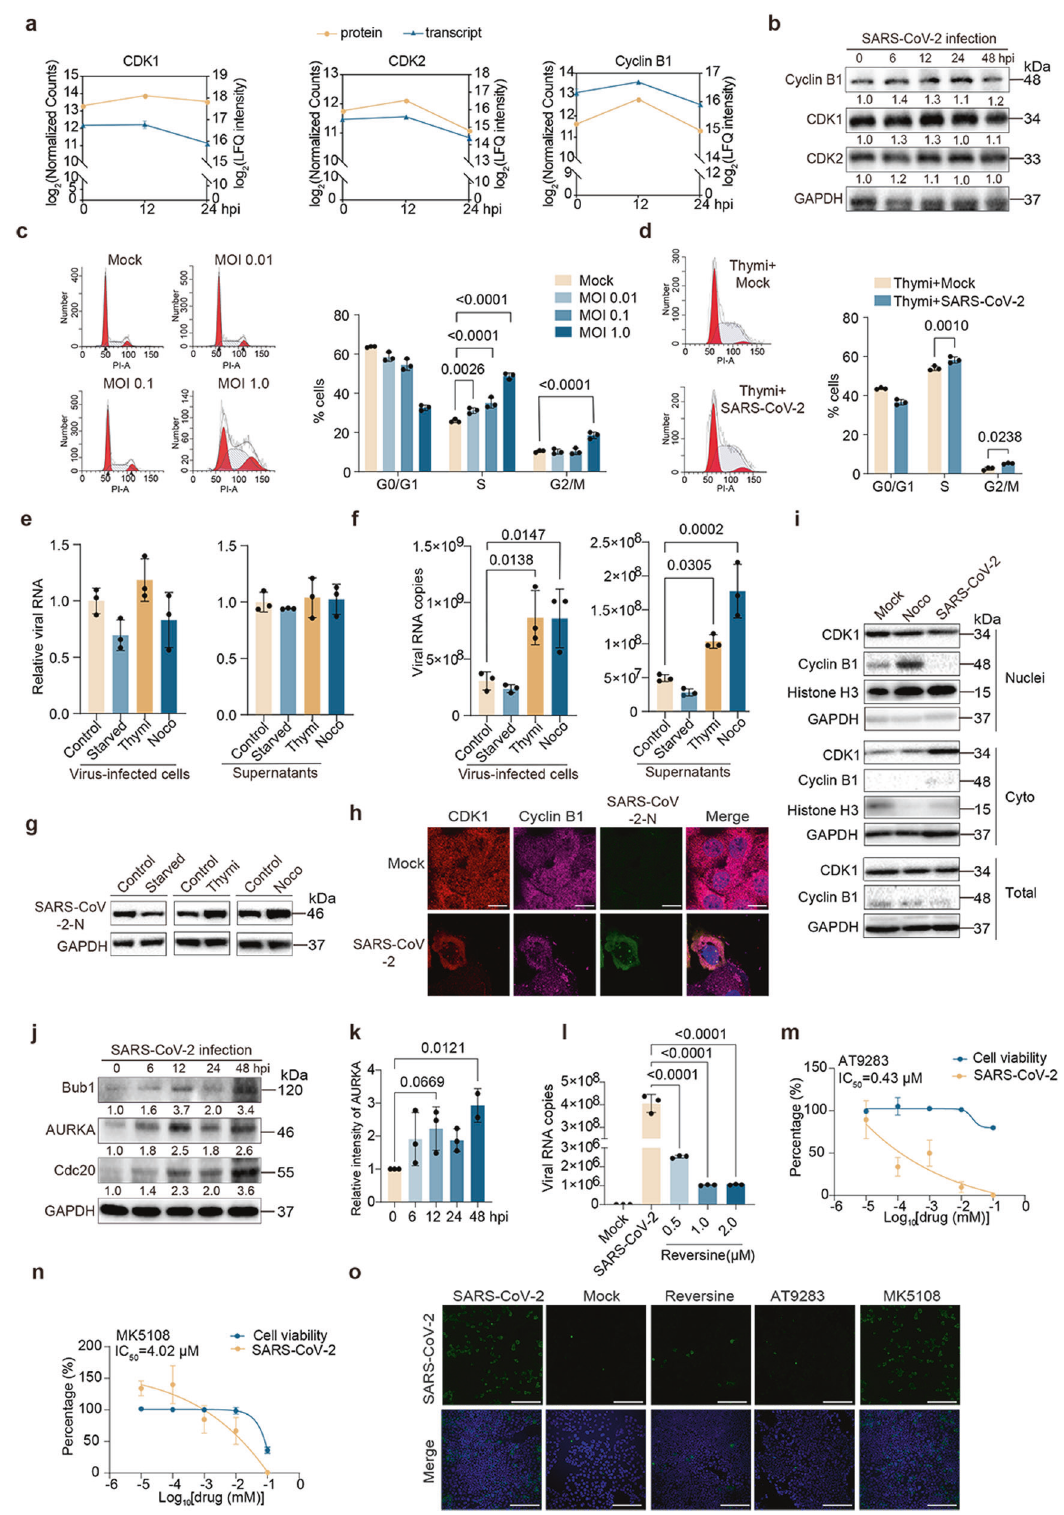
employed two inhibitors of AURKA, AT9283 and MK5108, to test their inhibitory effects on SARS-CoV-2 replication, showing that 0.01 μ M AT9283 had no signi fi cant effect on viral replication, viral replication, 10 μ M and 100 μ M AT9283 had an inhibitory rate